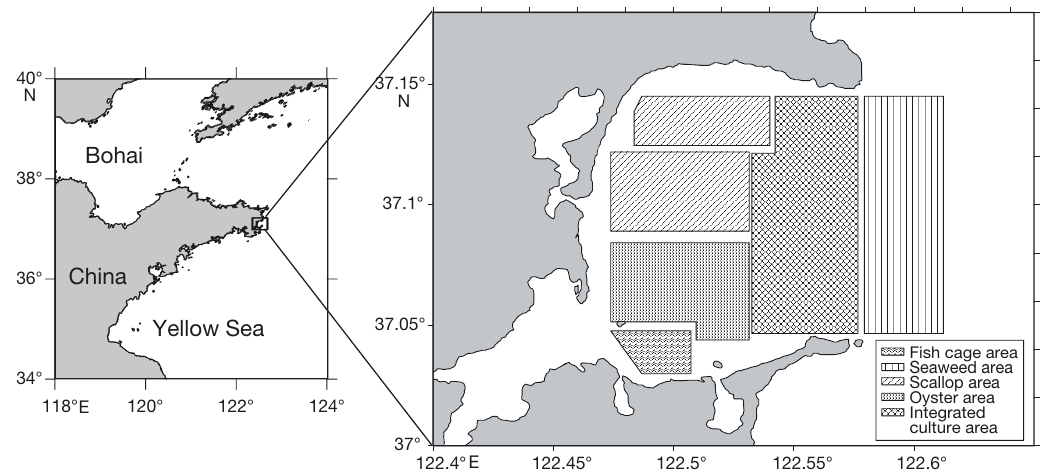
Fig. 1. Aquaculture areas in Sanggou Bay, Shandong Province,